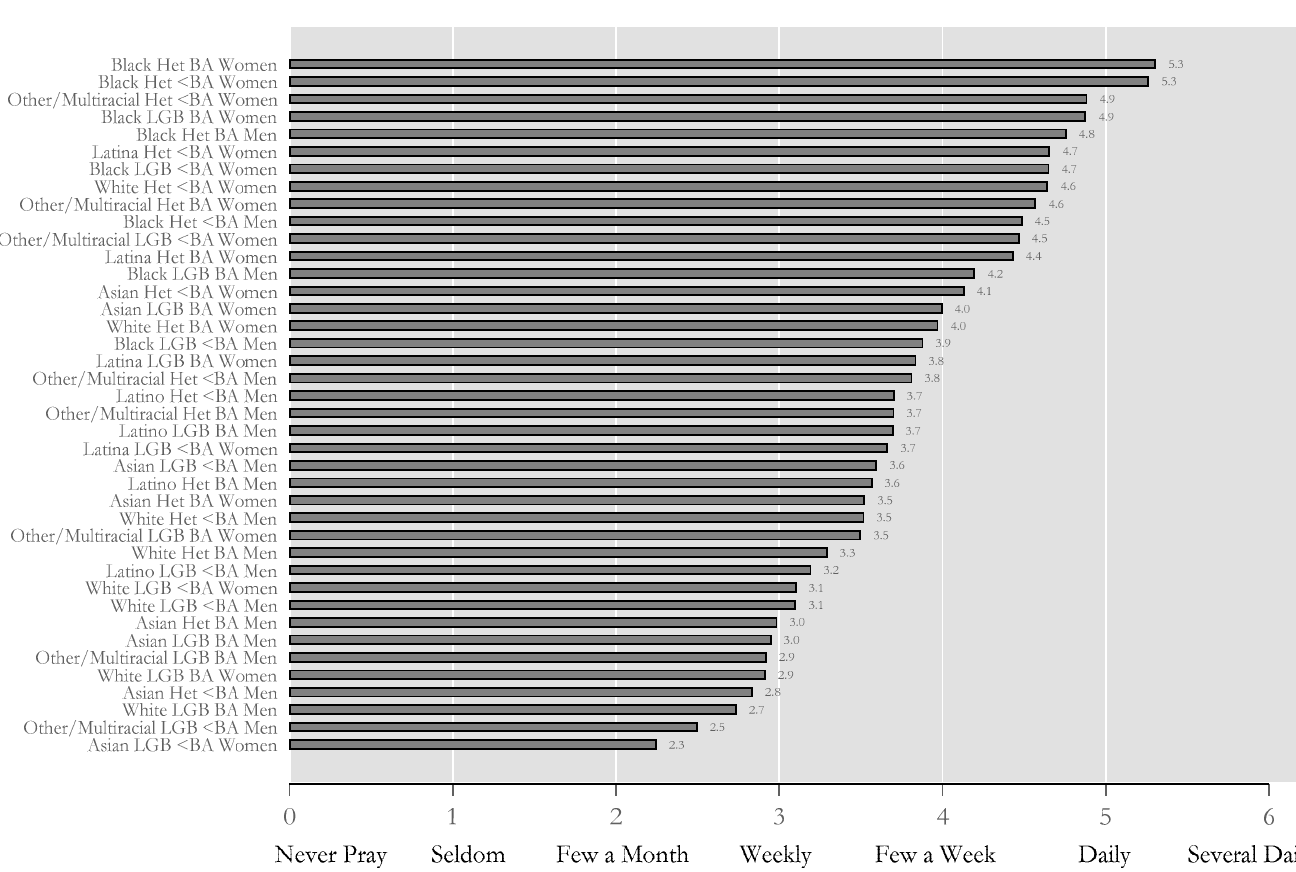
Figure 5. Prayer frequency across configurations of status characteristics, RLS (N = 33,183).